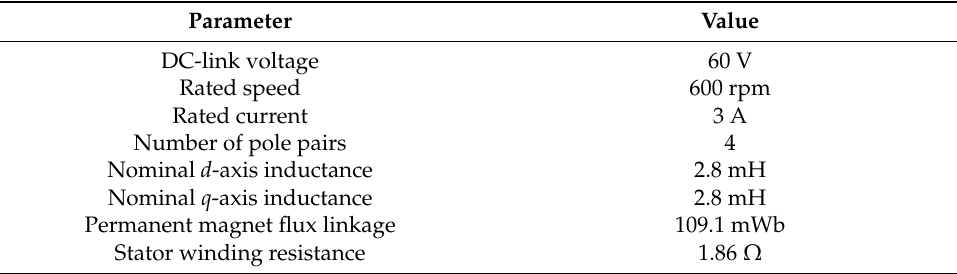
Figure 9. Test bench and electrical machines. Table 2. Design parameters of SPMSM.